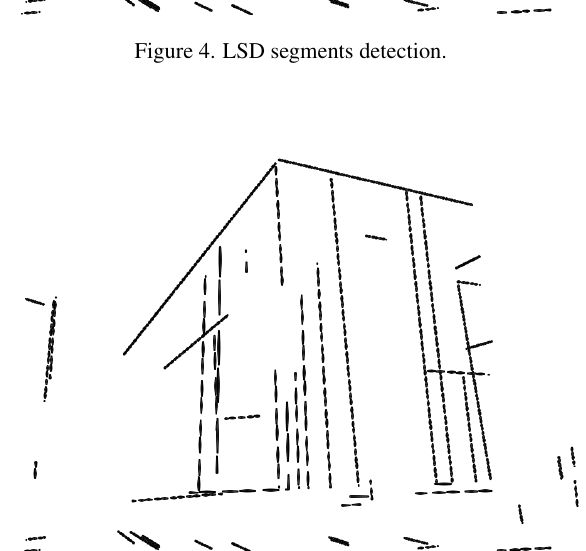
Figure 4. LSD segments detection.